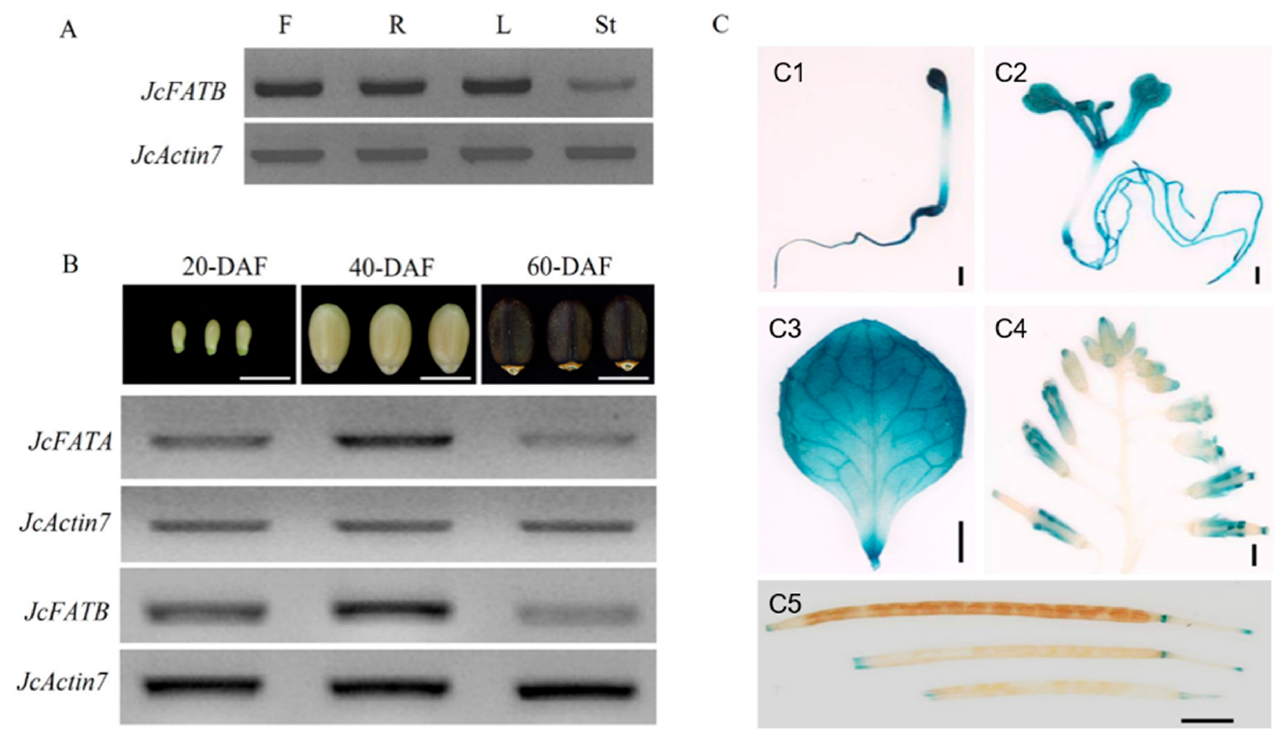
Figure 2. Expression profiles of JcFATA and JcFATB . ( A ) Expression of JcFATB in different tissues analyzed by semi-quantitative RT-PCR in J. curcas . F, flowers at 5 DAF (days after flowering); R, L, and St indicates mature roots, leaves, and stems. ( B ) Expression of JcFATA and JcFATB in developing seeds at 20, 40, and 60 DAF in J. curcas as analyzed by semi-quantitative RT-PCR. JcActin7 was used as an internal control for RT-PCR. Scale bars = 1 cm. ( C ) Expression profiles of JcFATB analyzed by GUS staining. ( C1 , C2 ) JcFATB : GUS seedlings at 5 and 15 DAG (days after germination); ( C3 ) A true leaf from a 30-DAG JcFATB : GUS plant; ( C4 ) The top part of inflorescence of the JcFATB :GUS plant; ( C5 ) Siliques at different development stages of the JcFATB :GUS plant. Scale bars = 1 mm.